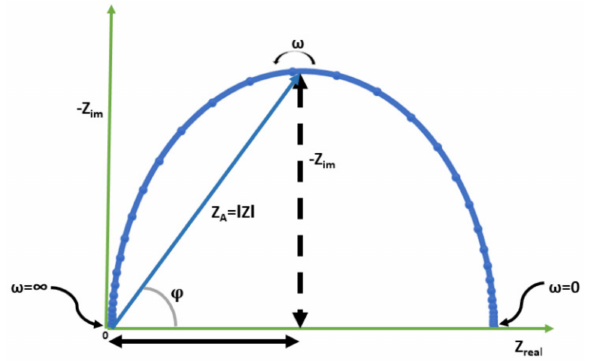
Figure 14. Impedance data represented as Nyquist plot. The Nyquist plot contains some valuable information, but has one major shortcoming. The data points on the plot cannot be correlated to the frequency that was used to record that specific point. To correlate the frequency dependence of a system against the phase shift, a Bode plot is used, as shown in Figure 15.